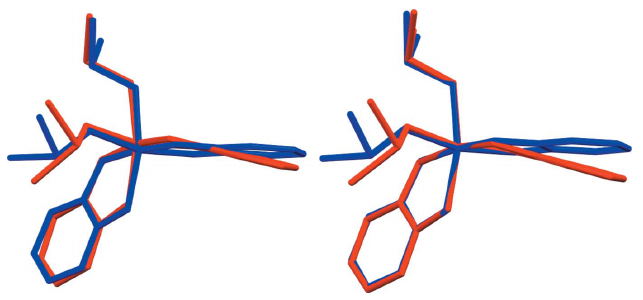
Figure 5 Root-mean-square overlays of the two independent molecules of 3 , after inversion of molecule B (red: molecule A ; blue: molecule B ). Left: fit based on all non-H atoms (r.m.s. deviation 0.459 A˚ ). Right: fit based on Ti and O atoms only (r.m.s. deviation 0.056 A˚ ).